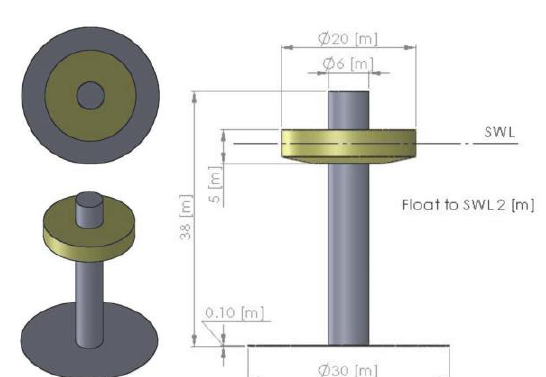
Fig. 7. Geometry dimensions for RM3 point absorber.